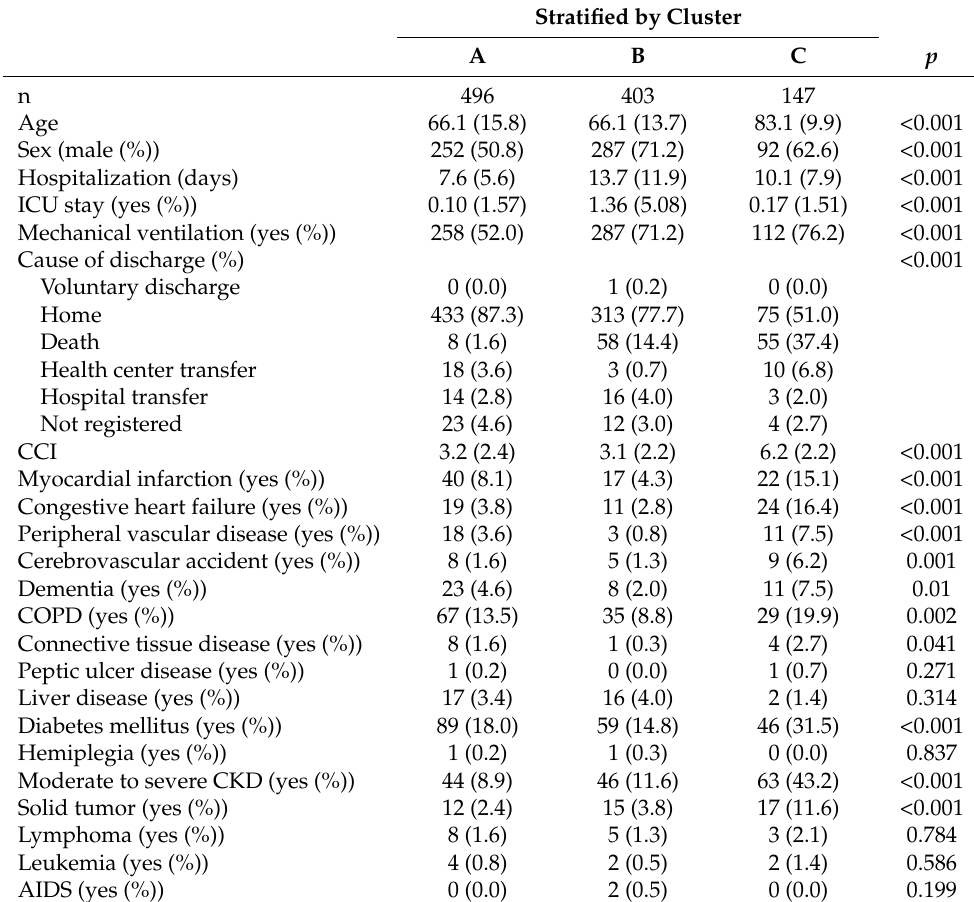
Table 2. Baseline and outcome characteristics of COVID-19 patients from DATA SAVE LIVES categorized by